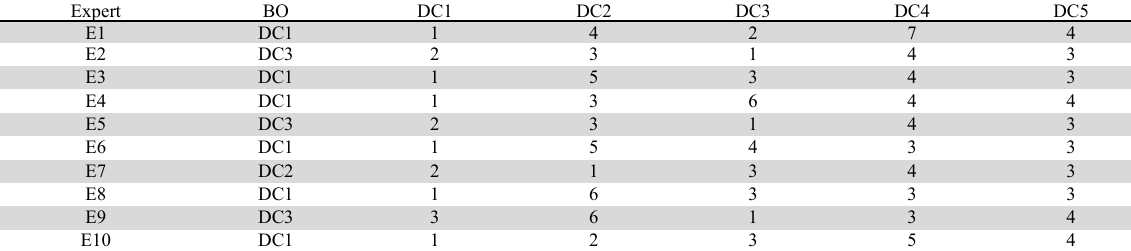
Data challenge preferences (Best to others) Expert